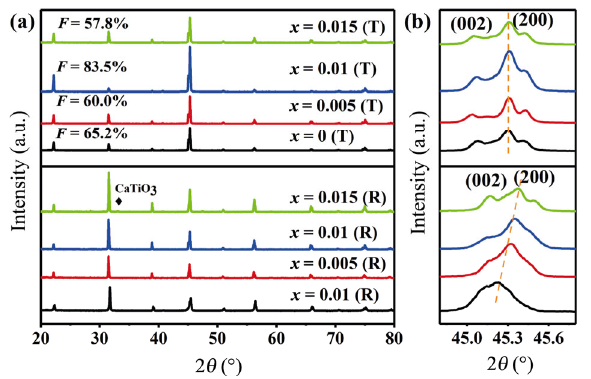
(a) XRD patterns of randomly oriented and textured x Er–BCTZ thick films; (b) zoomed XRD patterns at 2 θ around